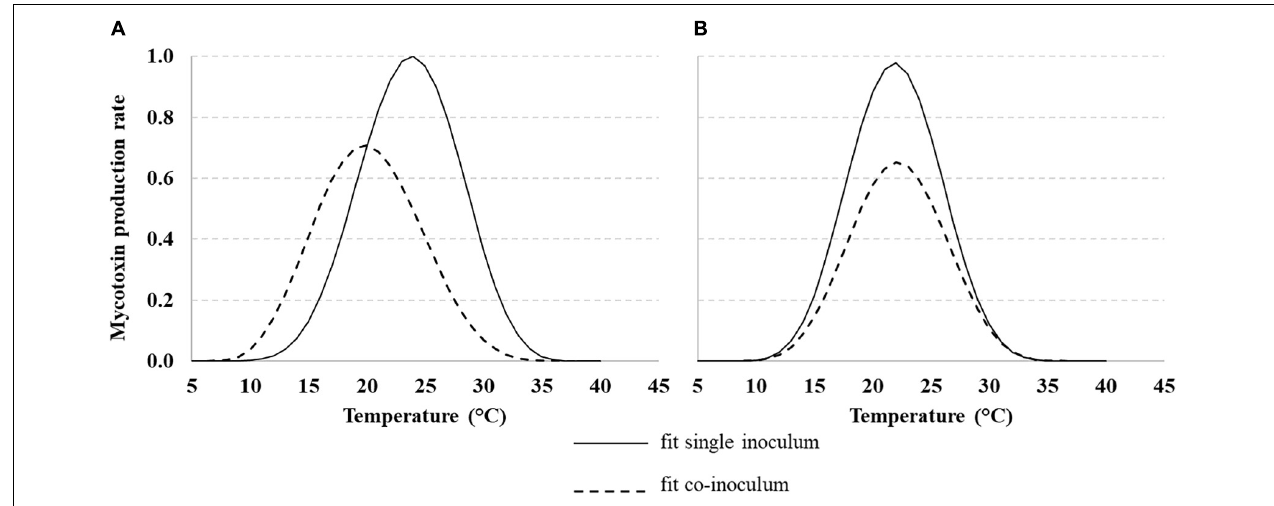
FIGURE 5 | Dynamic of aflatoxin B1 (AFB 1 ) (A) and fumonisins [FB1 + FB2 (FBs)] (B) production rate with Aspergillus flavus ( Af ) and Fusarium verticillioides ( Fv ) grown (solid line) or together (dotted line) under different T regimes (10–40 ◦ C). Data were fitted by a non-liner function (Eq. 1, Table 3 for equation